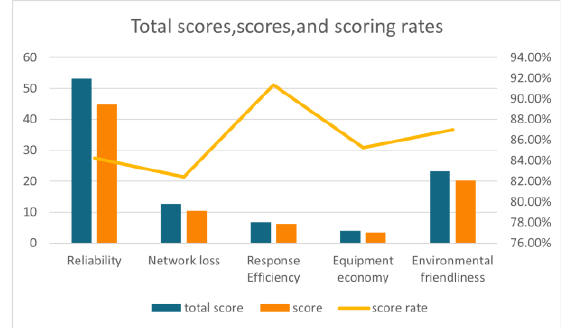
Figure 8. Total scores, scores, and scoring rates.